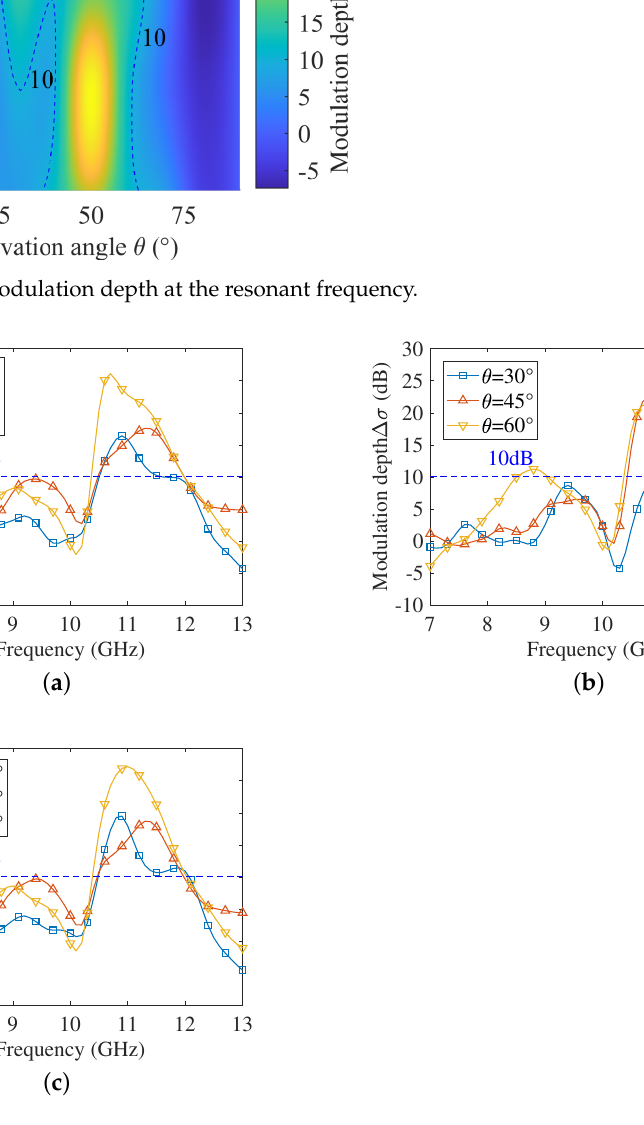
Figure 8. RCS modulation depth in different incident directions. ( a ) φ = 30°. ( b ) φ = 45°. ( c ) φ =